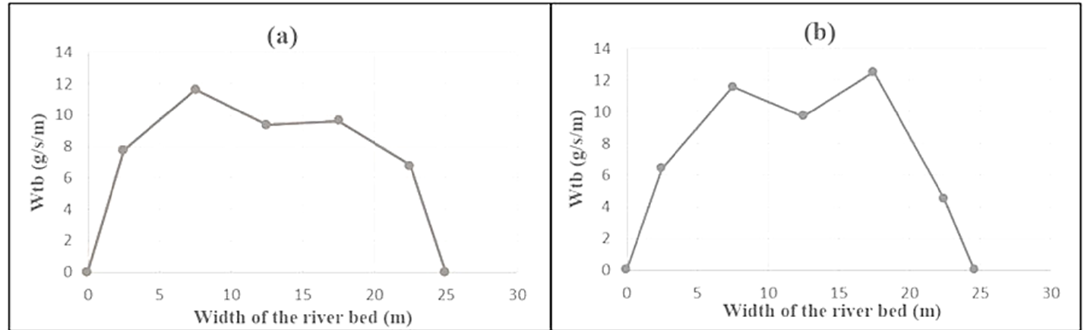
Figure 5. Presentation of bed load discharge at cross-section: ( a ) D2; ( b ) K3.